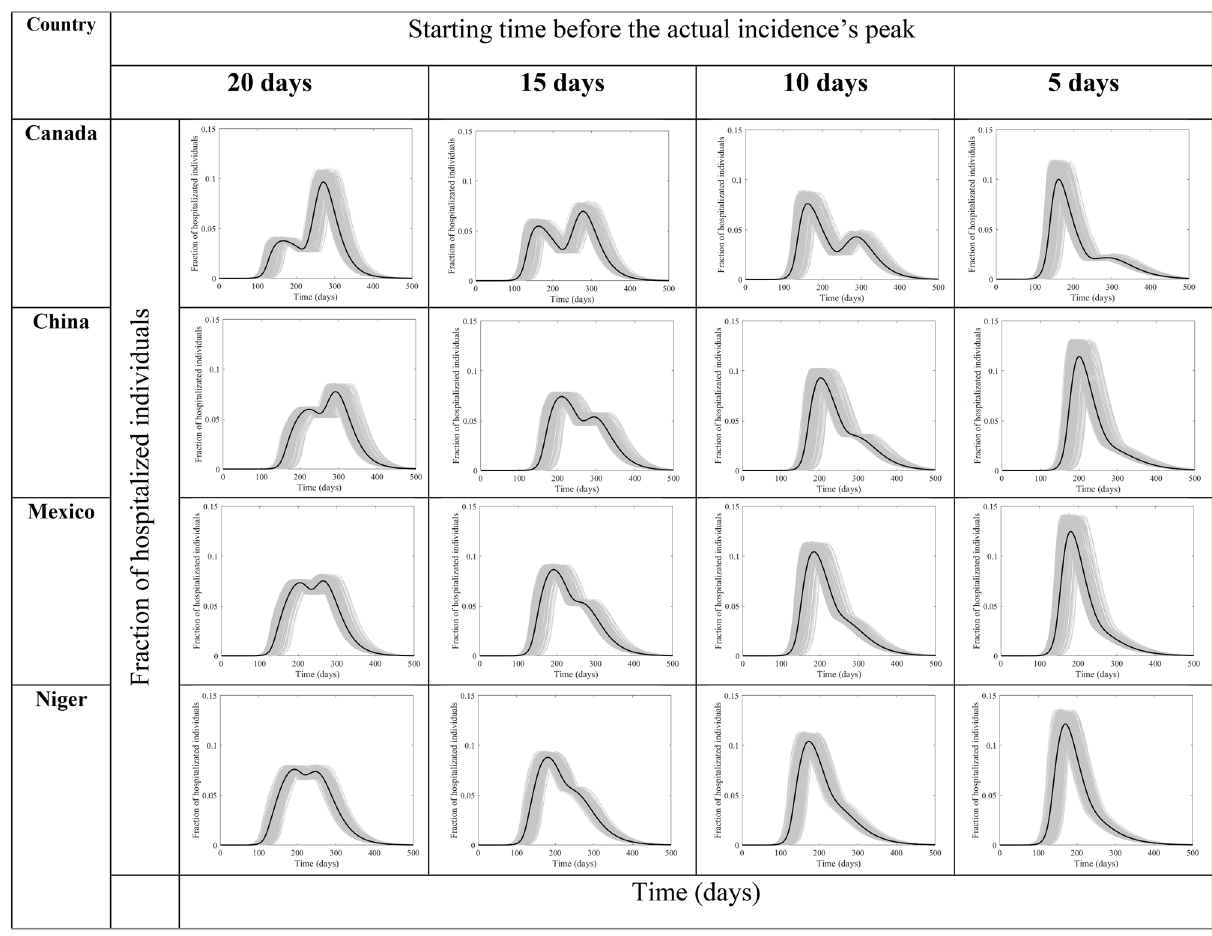
Figure 9. Hospitalization flux (proportion of COVD-19 cases requiring hospitalization) for Canada, China, Mexico, and Niger at four different times (days) of starting the lockdown before the peak. They are calculated at R 0 = 6.47 , with initial one adult mild infection. The grey curves are resulting from the stochastic model simulations and the black curve is the mean of those grey curves. They are all normalized by the population